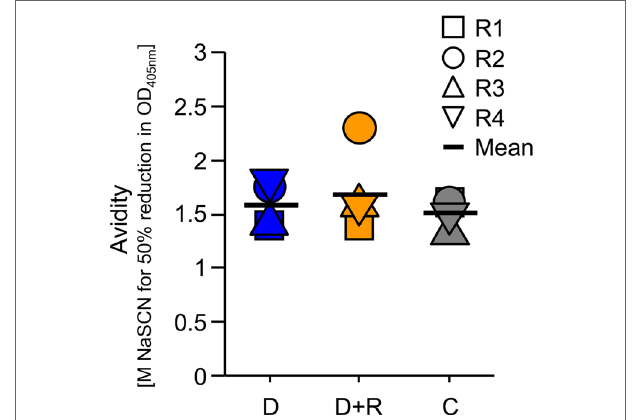
FigUre 3 | Determination of antibody avidity in the serum samples. The antibody avidity for the DiCo-Mix was assessed using the NaSCN- displacement enzyme-linked immunosorbent assay protocol and is defined as the NaSCN concentration (molar) required to reduce the OD 405 nm by 50% compared to the reference sample incubated without NaSCN. D: group of rabbits that received 50 µg DiCo-Mix; D + R: group of rabbits that received 50 µg DiCo-Mix and 50 µg of Pf Ron2L peptide at different injection sites; C: group of rabbits that were immunized with the DiCo– Pf Ron2L complex formed by mixing 50 µg of DiCo-Mix and 50 µg of Pf Ron2L. To facilitate the complex formation, the DiCo– Pf Ron2L mixture was incubated for 30 min at room temperature before formulation with the adjuvant and immunization.